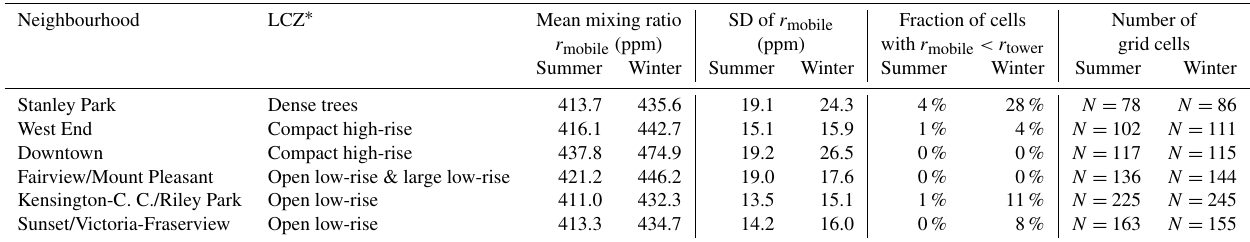
Table 2. Grid-averaged mixing ratios ( r mobile ), standard deviation of all grid cell means in the neighbourhood, and fraction of cells with r mobile < r tower per neighbourhood.